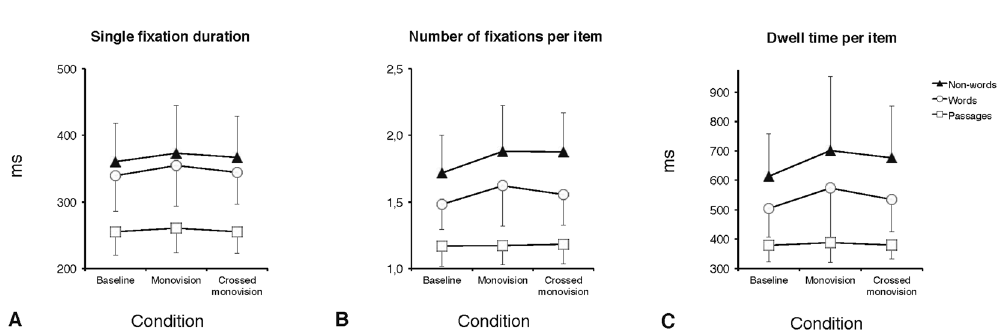
Figure 2. Group means for EM parameters: single fixation duration ( A ), number of fixations per item ( B ) and the dwell time per item ( C ). Data are separately presented for text passages, words, and non-words and as a function of the three experimental CL conditions (baseline, monovision, and crossed monovision). Error bars represent standard